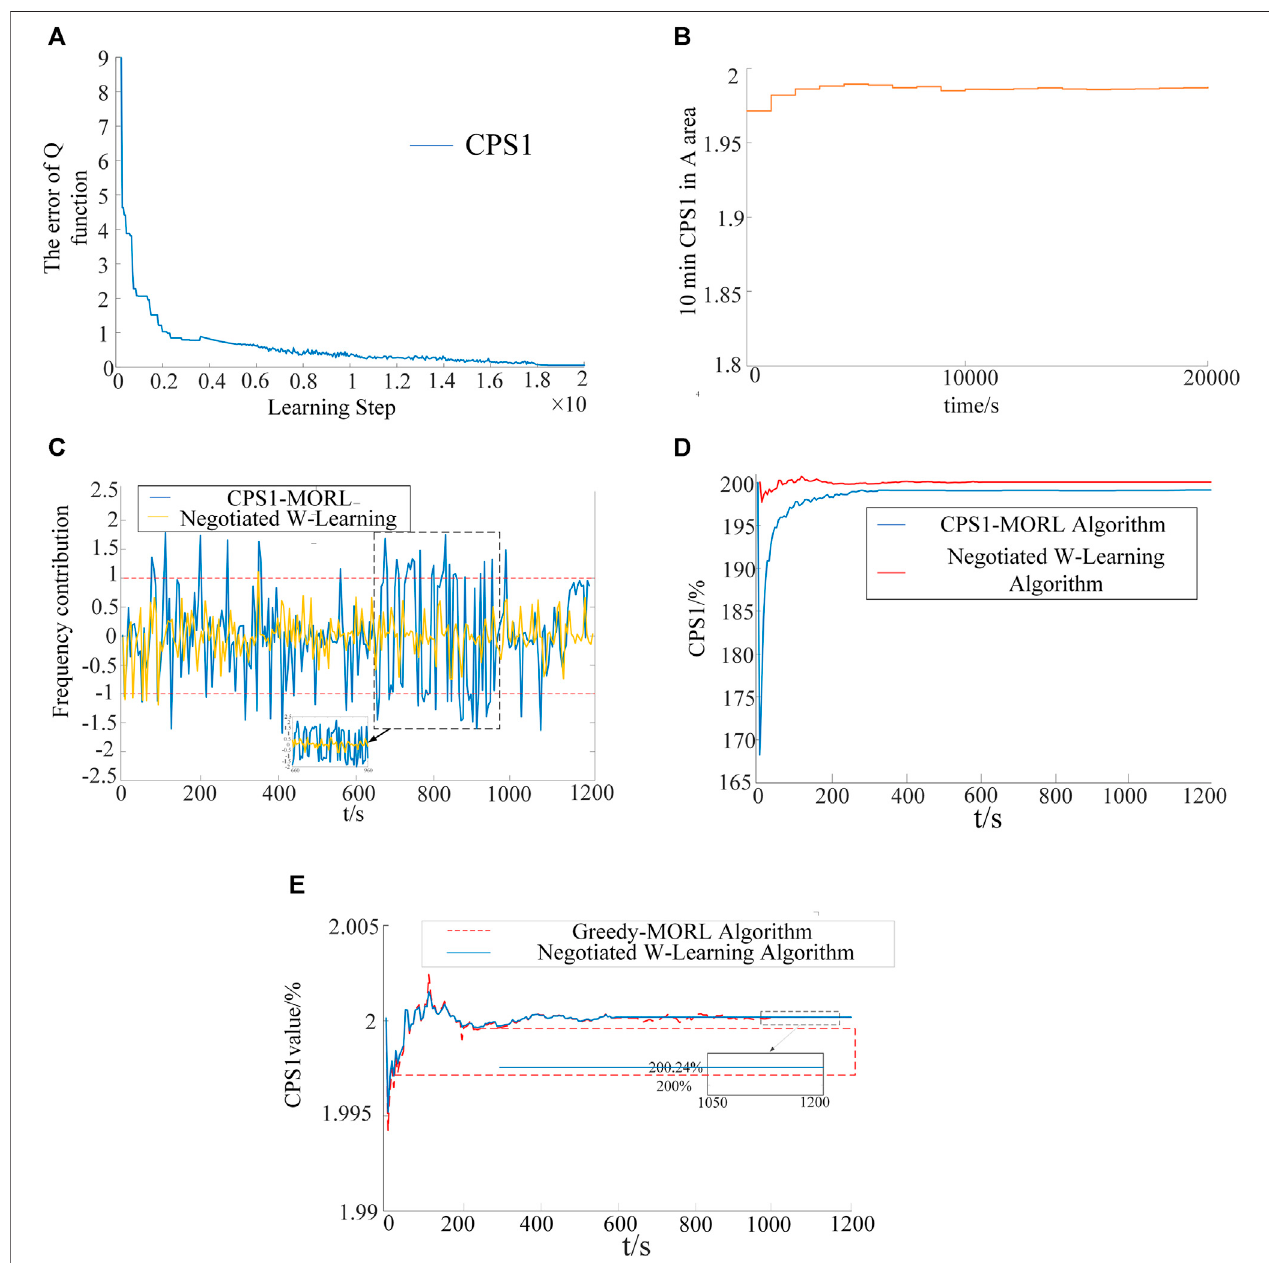
FIGURE 3 | Simulation results: (A) Differential convergence result of Q function under CPS1 objective, (B) CPS 1 avg - 10 − min curve, (C) Self-contribution curve, (D) Curve re fl ecting the change of CPS1 value, (E) The curve of CPS1.